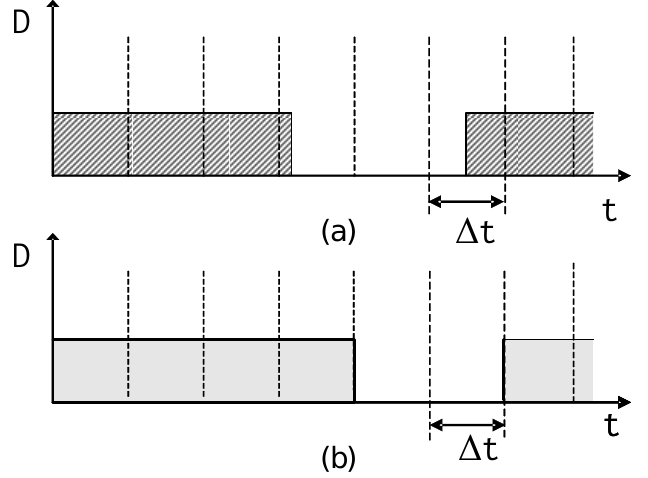
Figure 1. ( a ) Actual PWM generated by the controller; ( b ) PWM input considered by the